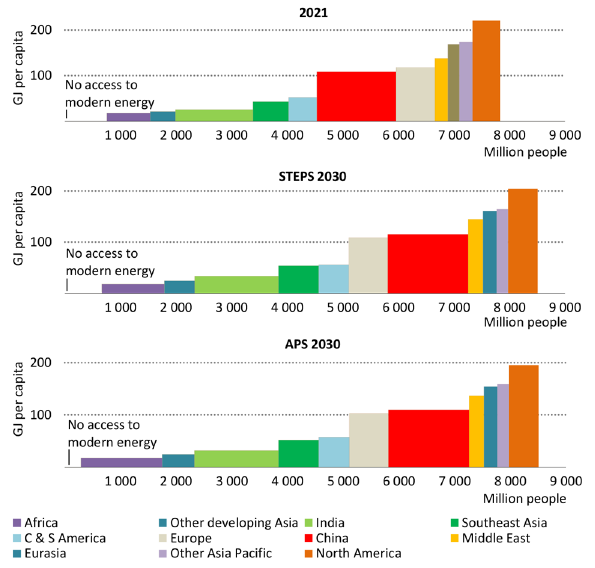
Figure 1. Regional trends in energy demand per capita under three scenarios [1].